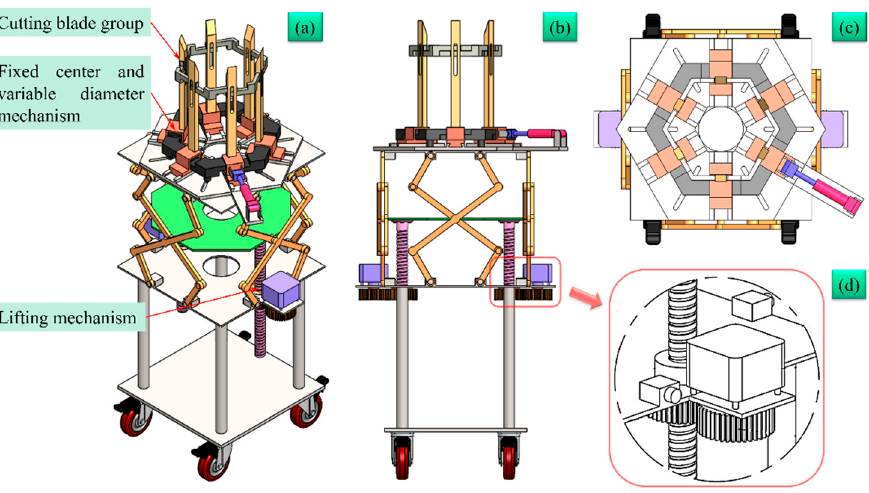
Figure 12. The de-handing mechanism with the functions of radial synchronous movement of blades and vertical lifting of the axial direction. ( a ) Schematic diagram of the structure of de-handing mechanism, ( b ) Front view of de-handing mechanism, ( c ) Top view of de-handing mechanism, ( d ) Partial enlarged view of the structure of the lifting